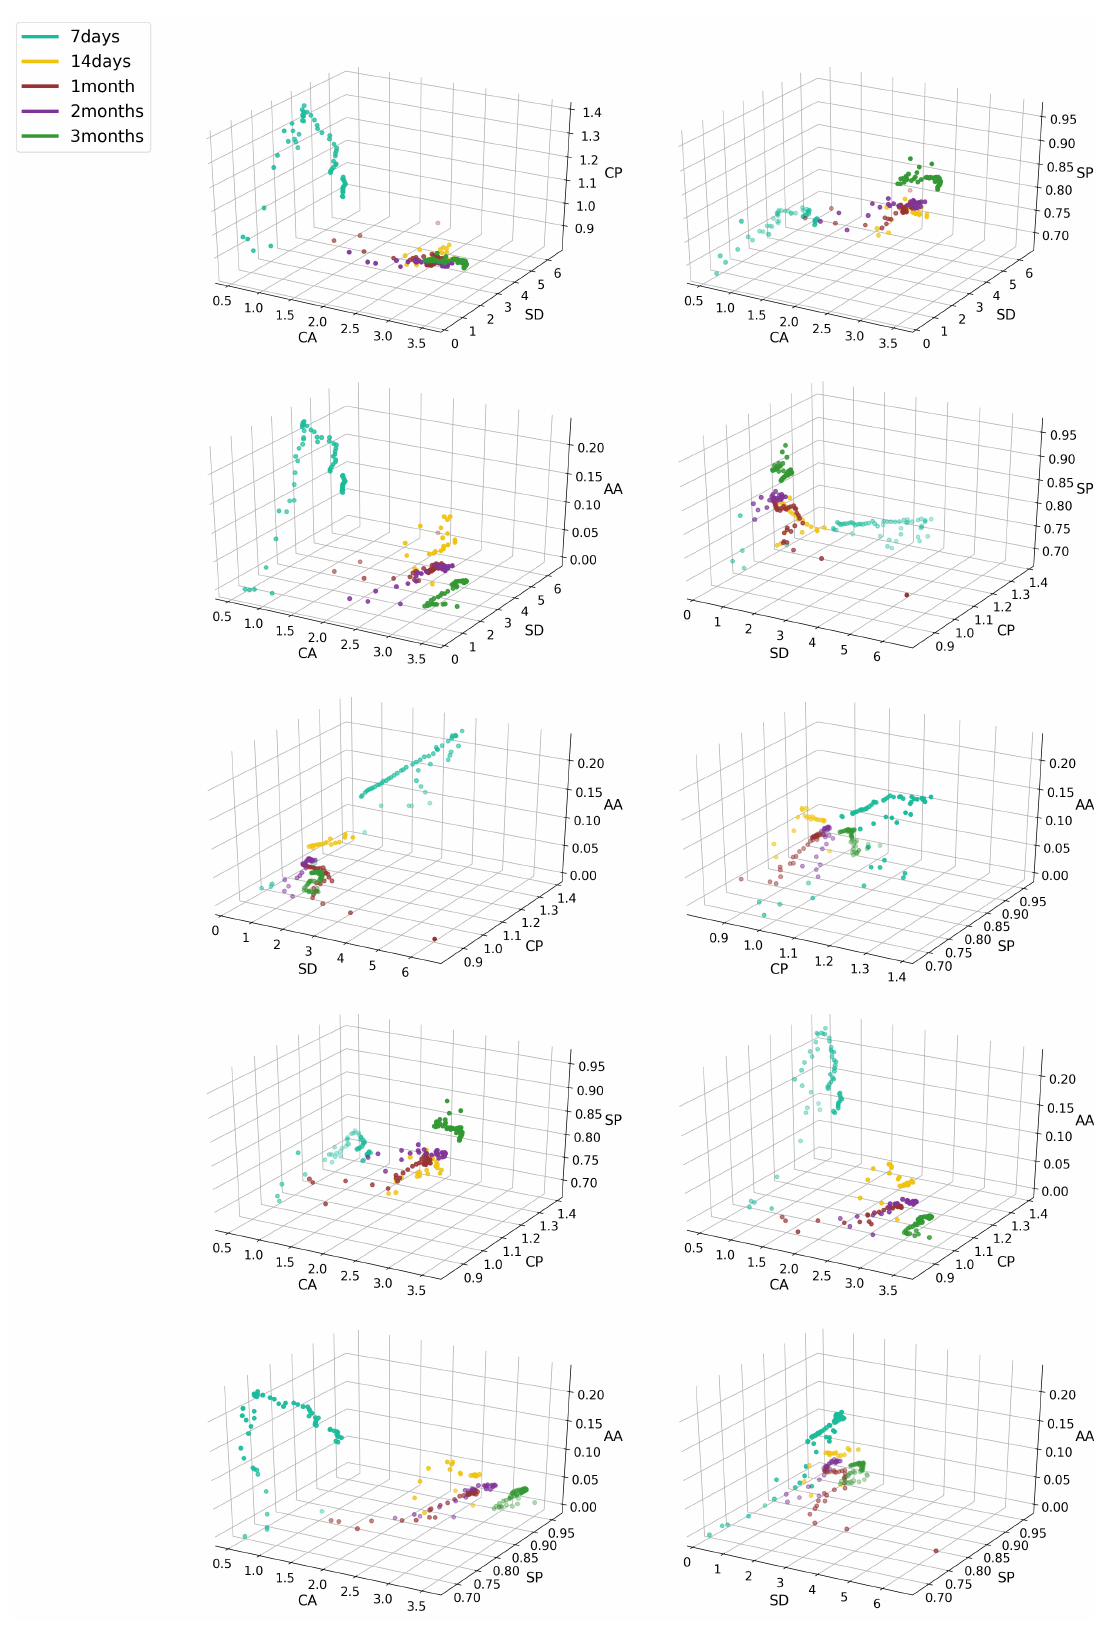
Figure A1. Dependence of objects in classes from all Activity